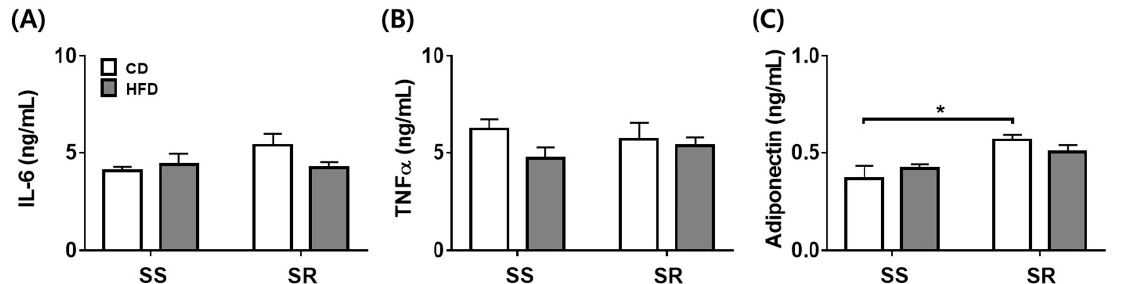
Figure 4. The effects of a high-fat diet on adipose tissue derived inflammatory factors in PVAT from SS and SR rats. Tissue levels of proinflammatory cytokines (interleukin-6 [IL-6, A ] and tumor necrosis factor α [TNF α , B ]) and an anti-inflammatory cytokine (adiponectin, C ) were detected via enzyme-linked immunosorbent assay (ELISA) in SS and SR rats fed a CD or HFD for 12 weeks. Graph, mean ± SEM of 6 independent experiments. Two-way analysis of variance followed by Tukey’s post hoc multiple comparisons test. * p < 0.05 vs. the SS CD group.